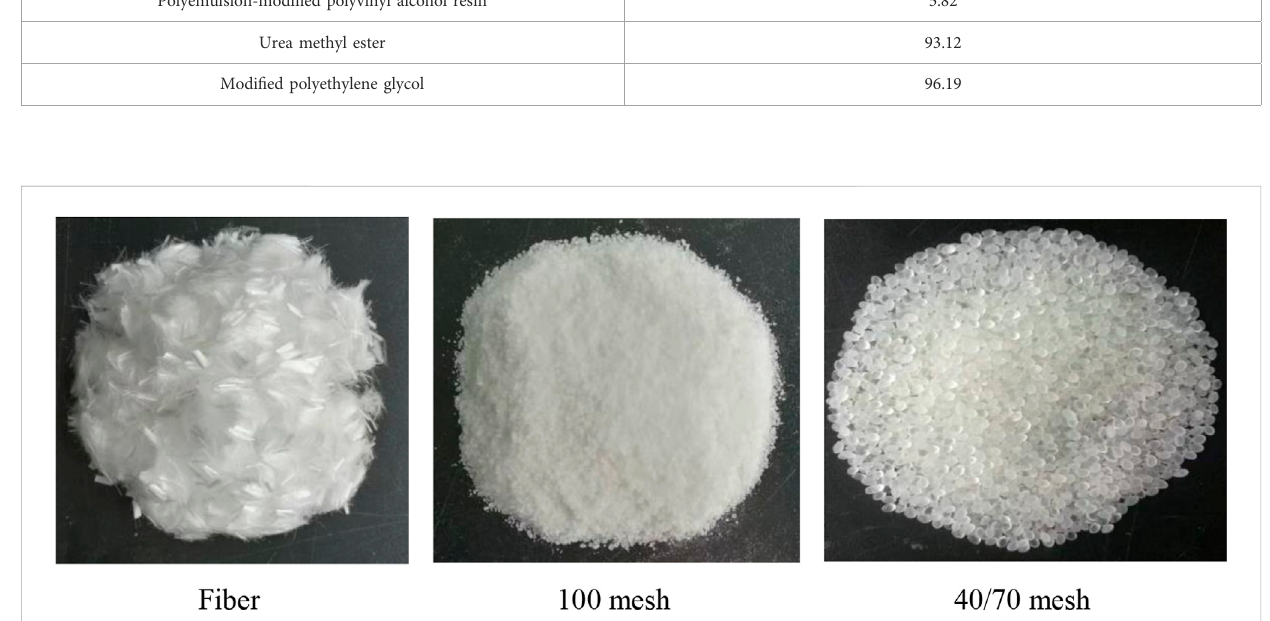
FIGURE 1 Polyemulsion-modi fi ed polyvinyl alcohol resin of different